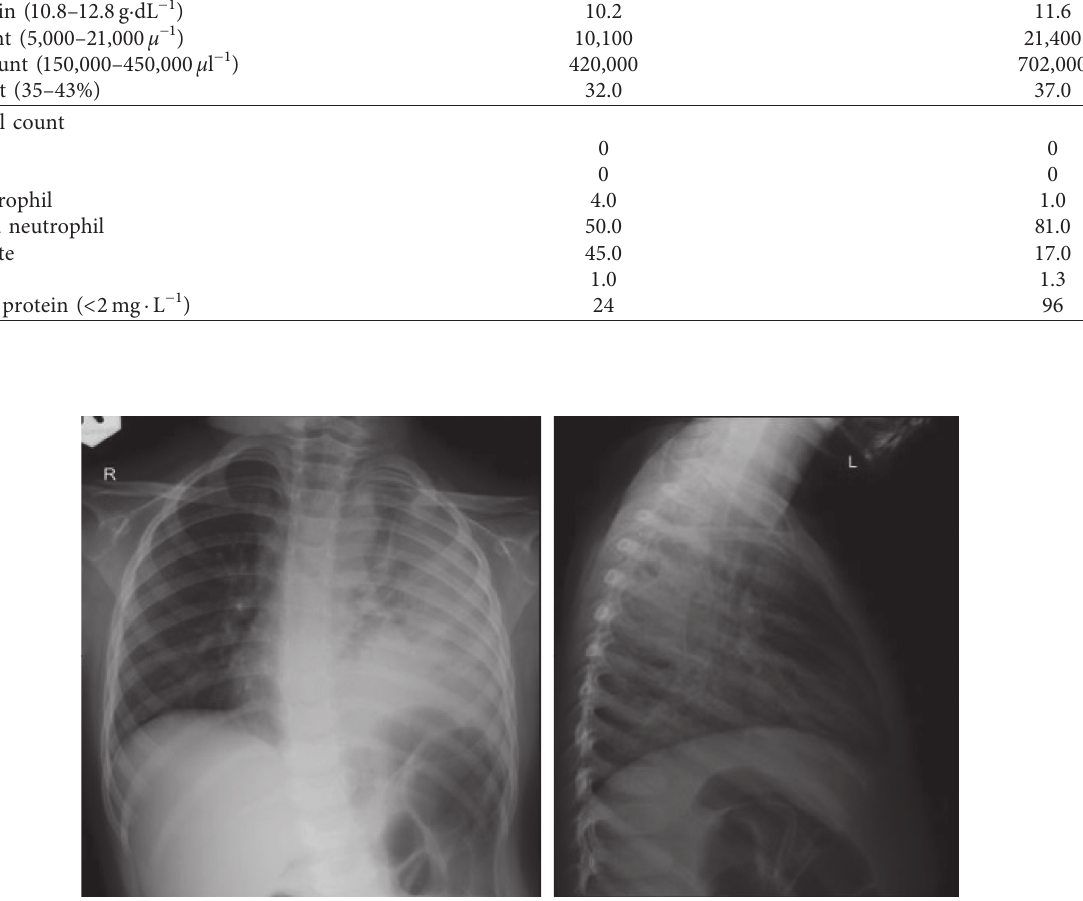
Figure 2: CXR AP and lateral view demonstrating focal area of consolidation in the left inferior lobe dominant. On the AP view, there are multiple small lucency in the left lung field suspicious for possible congenital pulmonary airway malformation (CPAM) and possible pneumonia with air cavitation. Compared to the previous CXR (Figure 1), no lucency was observed.